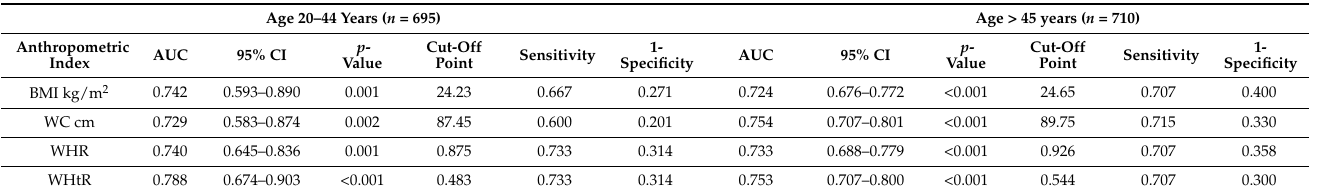
Table 5. Area under the curve and optimal cut-off points for anthropometric indices to predict diabetic mellitus: stratified by age